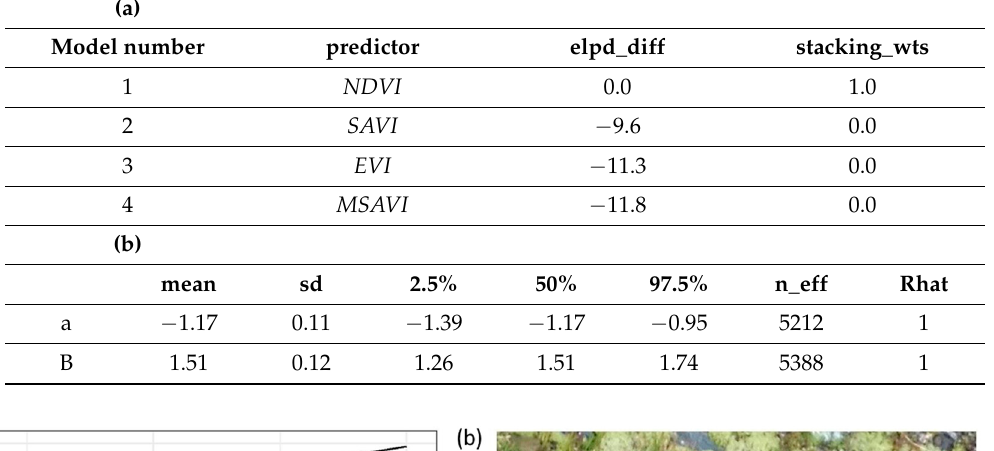
Table 4. Model evaluation using (a) loo package (leave-one-out cross-validation) [90] and (b) posterior distribution summary statistics for the model using the NDVI as predictor. The model evaluation with loo includes the model number, predictor, difference in their expected predictive accuracy (elpd_diff) and stacking weights (stacking_wts). The posterior distribution summary statistics is displayed as mean and standard deviation (sd) for the intercept (a) and slope (B); addi- tionally, the 2.5%, 50% and 97.5% posterior percentiles as boundaries of the 95% credible interval are shown, as well as the effective sample size (n_eff) and Rhat.